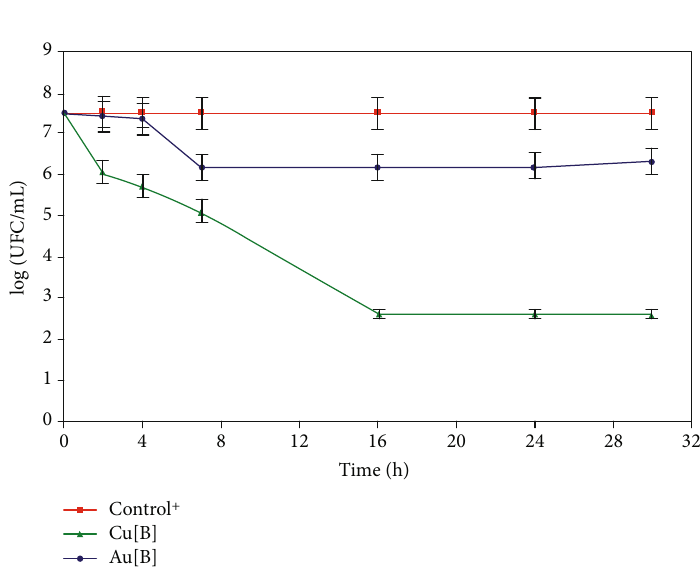
Figure 11: Death curve for E. coli exposed to the agent Au [B]-Qs and Cu